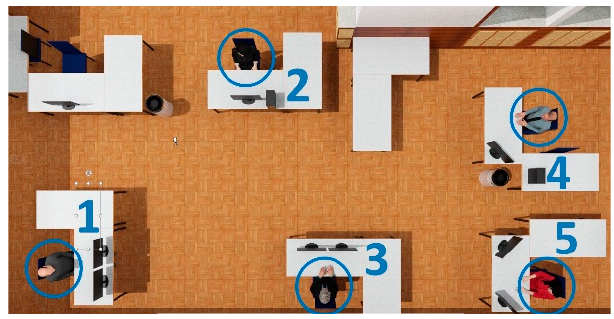
Figure 10. Overview of the person locations in the room.